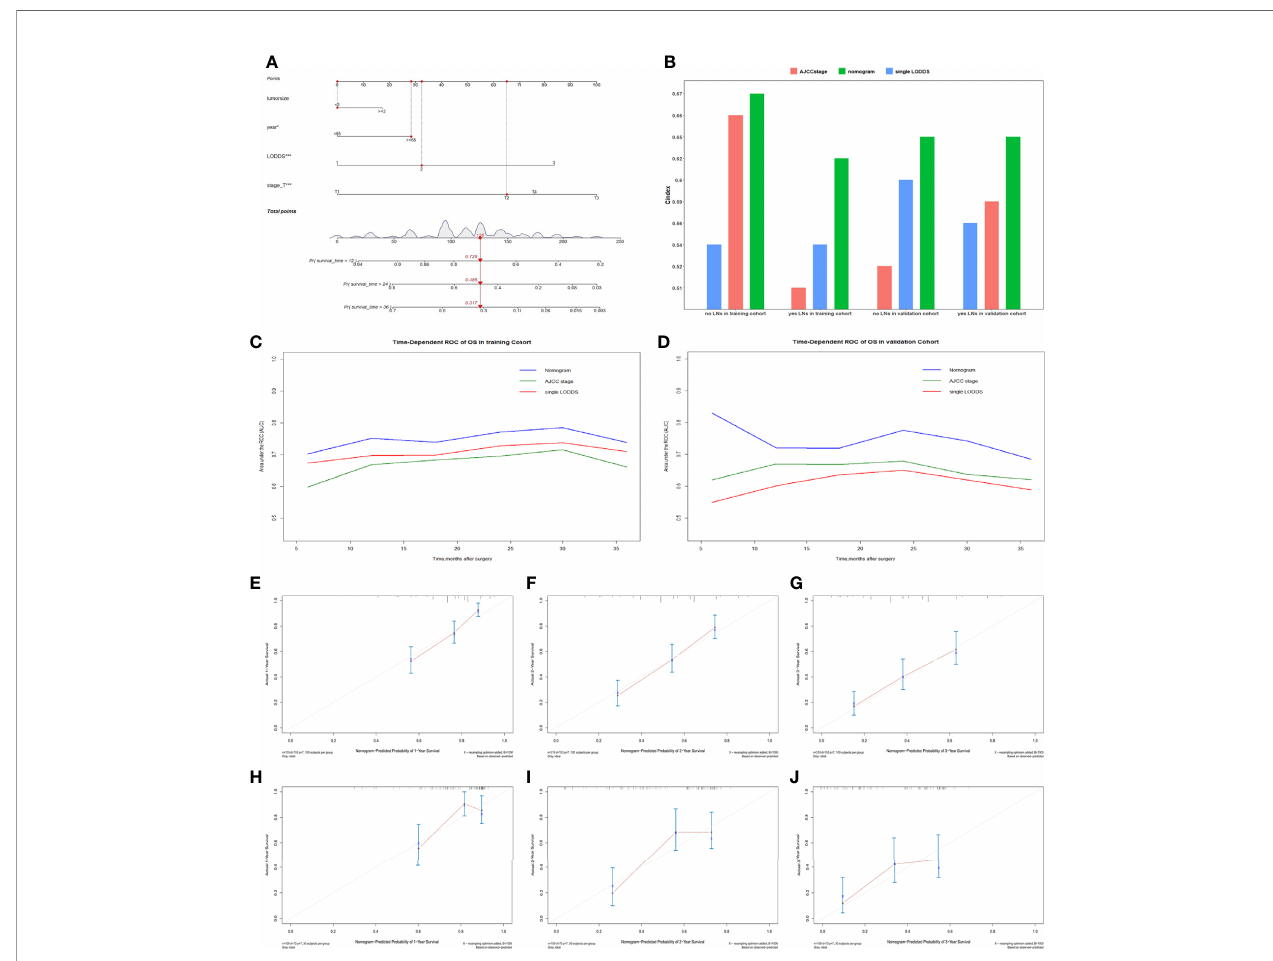
FIGURE 2 | (A) The nomogram for predicting OS for pCCA patients. (B) Boxplot of C-index in four subgroups. (C) The time-dependent AUC of the nomogram in training cohort. (D) The time-dependent AUC of the nomogram in the validation cohort. (E – G) Calibration curves showed the probability of 1-, 2-, and 3-year OS between the nomogram prediction and the practical observation in the training cohort. (H – J) Calibration curves reveal the probability of 1-, 2-, and 3-year OS between the nomogram prediction and the practical observation in the validation cohort.